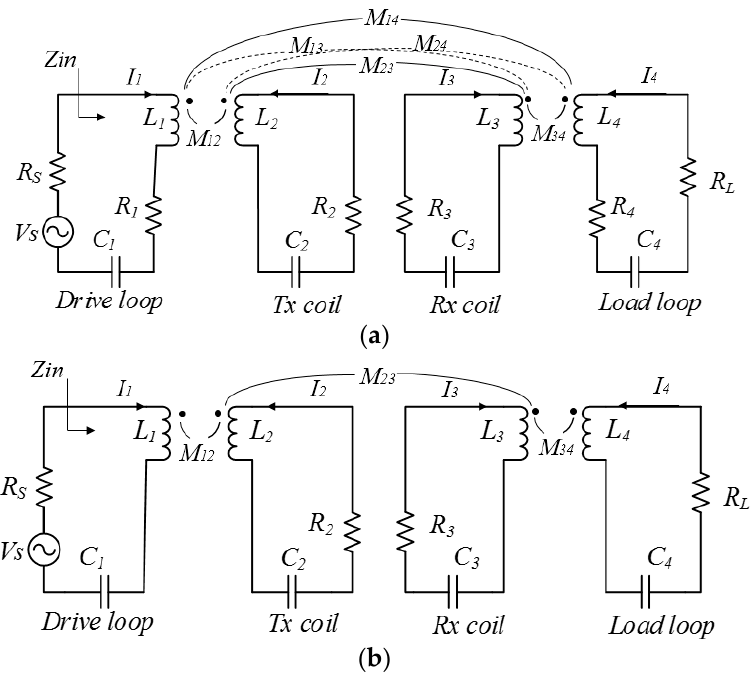
Figure 2. The equivalent circuit model of the four ‐ coil WPT system. ( a ) The complete model. ( b ) The simplified model.